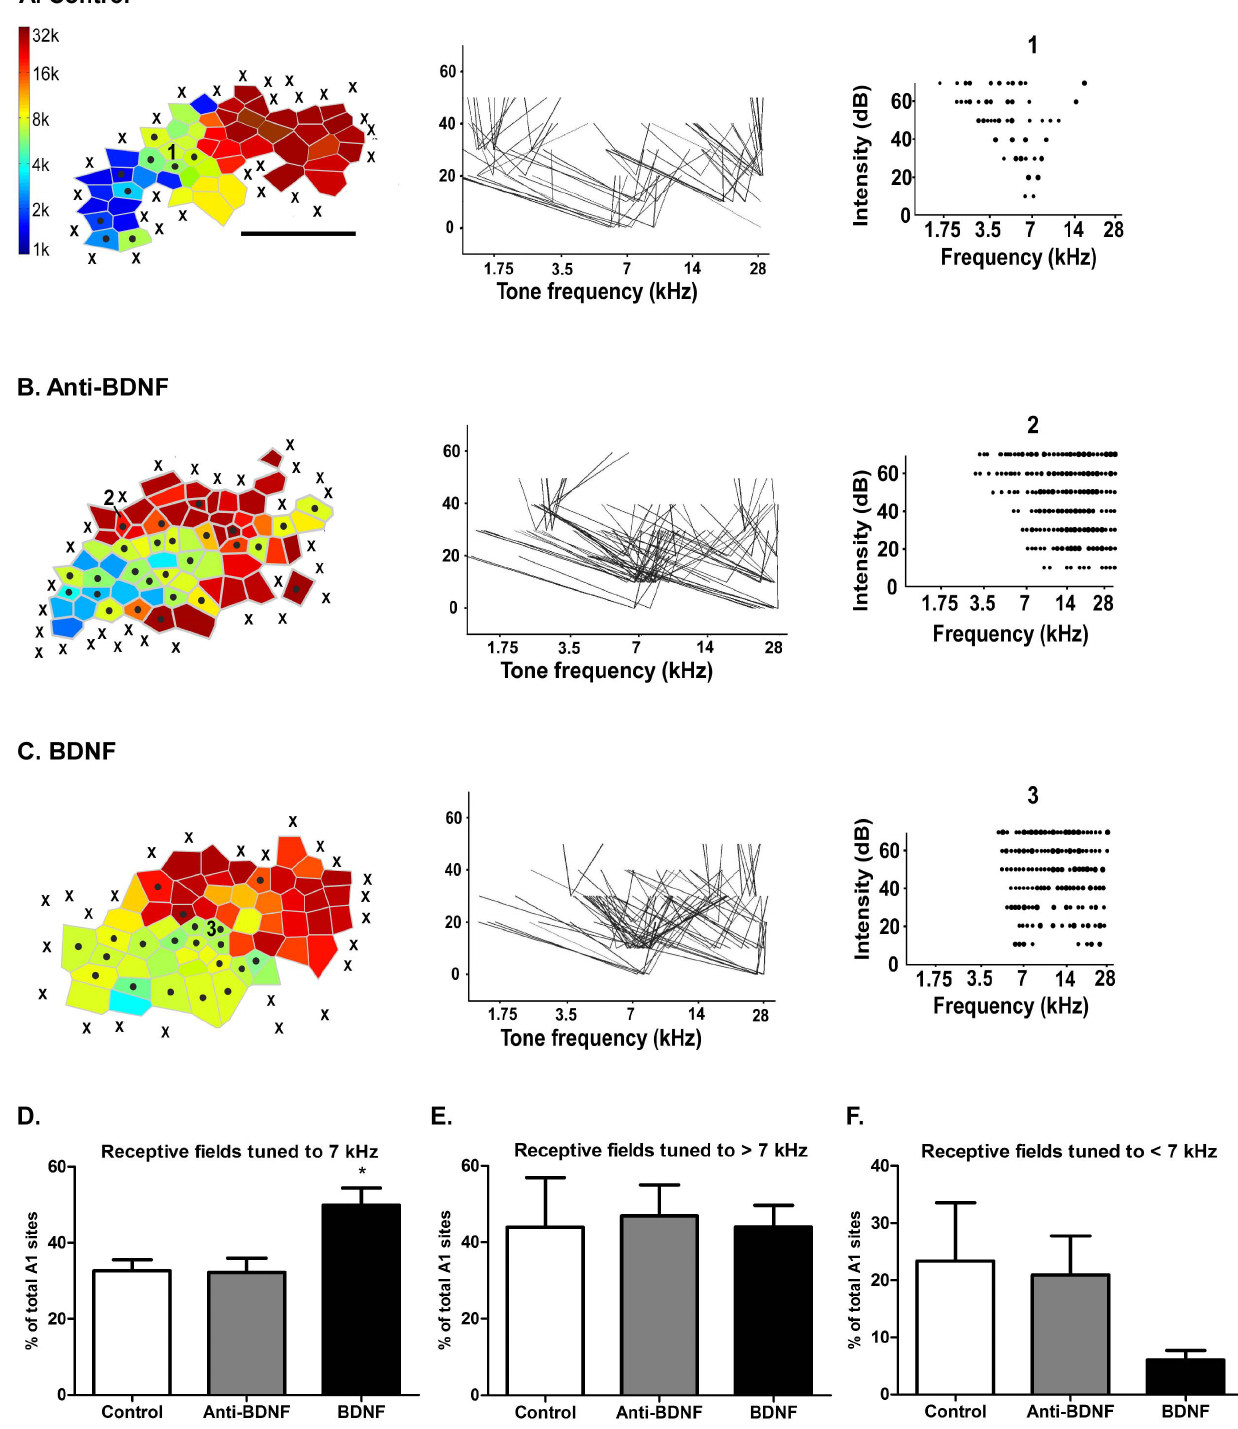
Figure 1. Manipulation of BDNF signaling during critical period affects the tonotopic organization, receptive fields and cortical representation of A1. (A, B, C) Tonotopic maps (left) of control, anti-BDNF, and BDNF groups; x =no tone-evoke responses; circle inside polygon =multi/flat-peaked sites. (Center) Distributions of tuning curves from illustrated map. The pair of joined lines represents the receptive field of each recorded site, and the apex indicates the threshold of activation of these sites. (Right) Representative receptive field from each displayed map (see number inside maps). (D) Receptive fields tuned to 7 kHz 6 0.3 octave were significantly increased in the BDNF group compared to control and anti-BDNF groups (F=7.3, p , 0.05, ANOVA). (E, F) The proportion of receptive fields tuned to frequencies higher than 7 kHz 6 0.3 octave (A) or lower than 7 kHz 6 0.3 octave (B) were not significantly different between groups. Values are means 6 SEM. * p , 0.05. Calibration bar=1 mm.